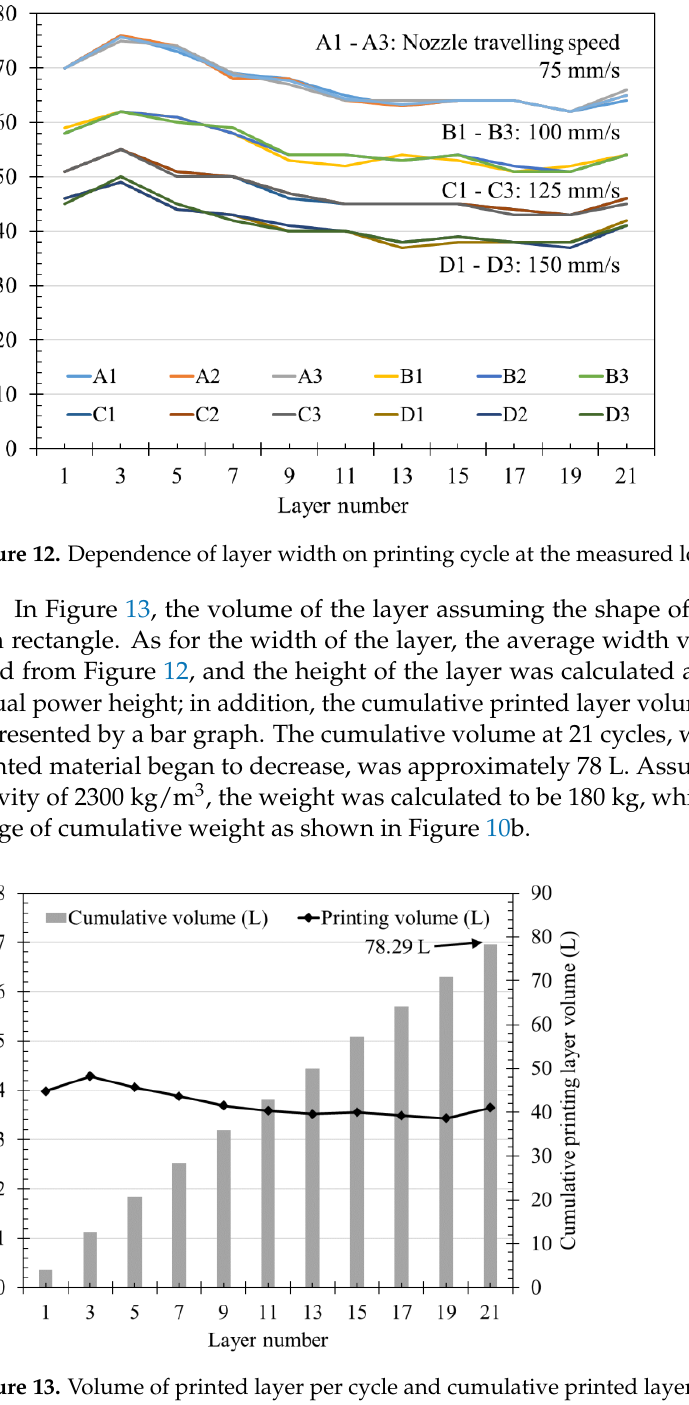
Figure 11. Weight decreasing ratio during pumping: ( a ) weight change ratio of pumped mortar; ( b ) mean weight change ratio and standard deviation of pumped mortar.